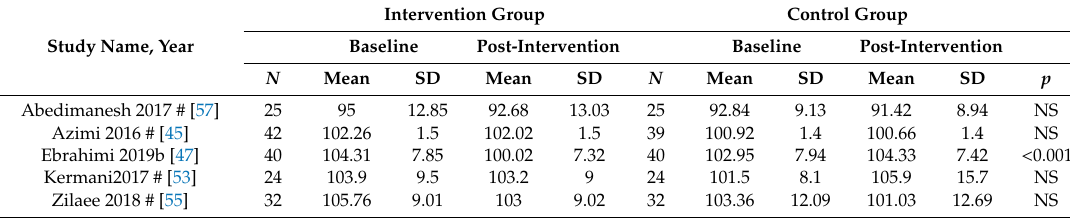
Table 10. Summary of findings for waist circumference